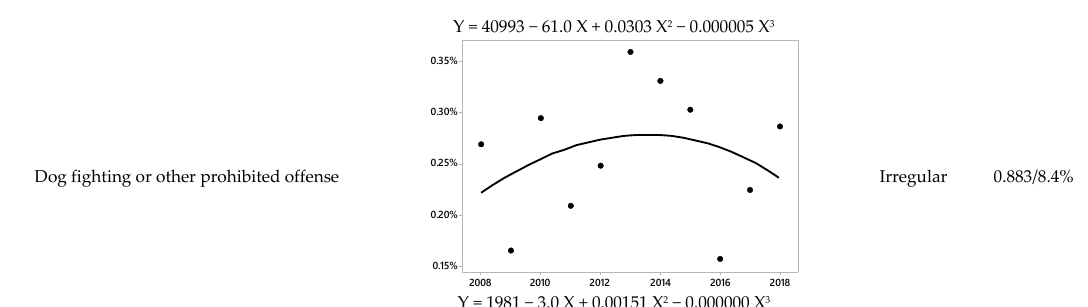
Figure 2. Polynomial regression of each complaint code. The X axis represents the year, and the Y axis represents the prevalence of the complaint code.